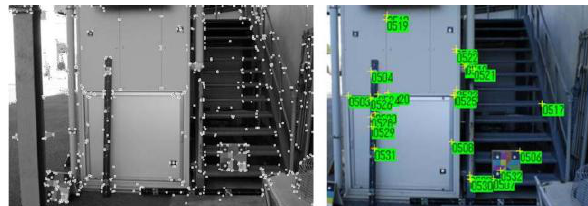
Figure 7. Result of feature points detection Left: Ends of edges, Right: Feature points for automatic orientation